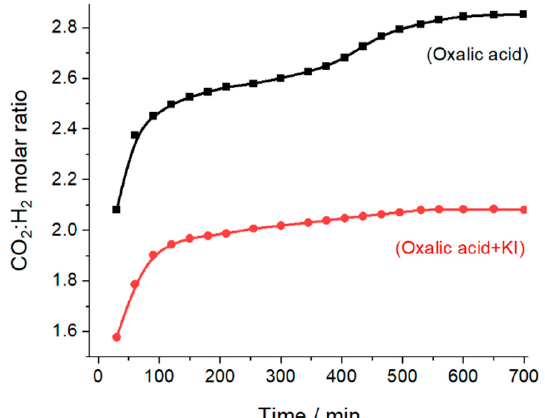
Figure 5. The ratio between the evolved CO 2 /H 2 amount with and without the presence of KI. A 50 mL aqueous suspension containing 1.11 mmol L − 1 oxalic acid at pH ~3 on Pt/TiO 2 . A longpass filter with a cut-on wavelength of 310 nm was used.